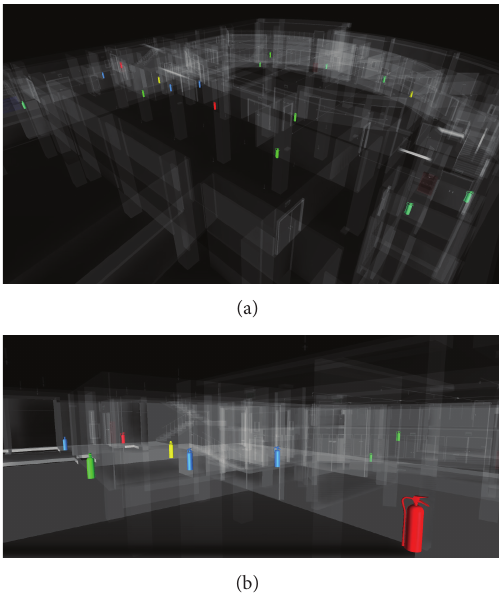
Figure 3: The different maintenance statuses of FMM through visu- alized and colorized BIM